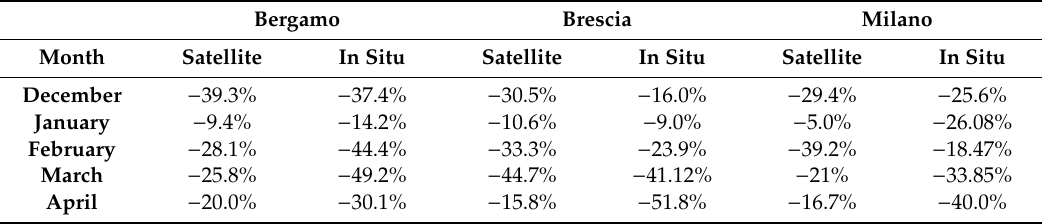
Table 3. Monthly percentage variations of NO 2 concentrations for the month December 2019–April 2020 to December 2018–April 2019, as measured by TROPOMI Level 3 data and in situ stations.